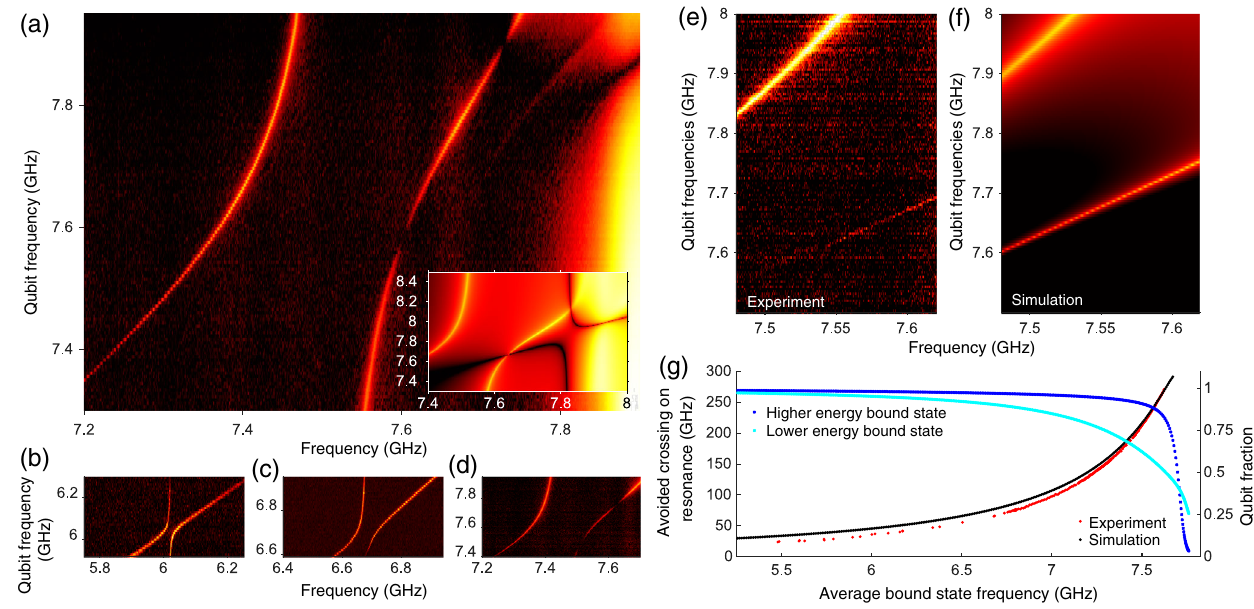
FIG. 3. Interacting bound states. — Interaction between bound states is characterized by the avoided crossing (observed in S 21 measurement) that arises while tuning one qubit ( y axis) through resonance with the other (fixed). (a) An avoided crossing of 240 MHz is observed when the fixed qubit is at 7.73 GHz. The two points where transmission amplitude of a bound state dims are understood as the bound-state peak being resonant with the qubit frequency. (a), inset — Hopping model simulation of the one-excitation manifold is consistent with experimental observation. The lamb shift in the hopping model originates from next-nearest-neighbor interaction between coupled cavities. (b),(c),(d) Tunable bound-state interaction strength is illustrated in example bound-state avoided level crossings for a fixed qubit whose bare frequency is circa 6.125, 6.75, and 7.625 GHz. As qubits are detuned further from the band edge, bound states are more tightly localized, reducing overlap and thus reducing interaction. (e),(f) Transmission when the qubits are on resonance across a range of qubit frequencies in the experiment and the simulation, respectively. The uneven linewidths of the two bound states when they occur at the same frequency suggest they are symmetric (higher-frequency bound state) and antisymmetric (lower-frequency bound state) states (see main text). (g) Bound-state avoided crossing and qubit population (from simulation) as a function of average bound-state frequency. A steady reduction in interaction strength occurs with increasing detuning from the band edge (moving deeper into the band gap) due to increasing localization of the bound states. Hopping model simulation (black) captures this detuning-dependent behavior observed in experiment (red). Near the band edge, both bound states (blue and cyan) have a significant photonic